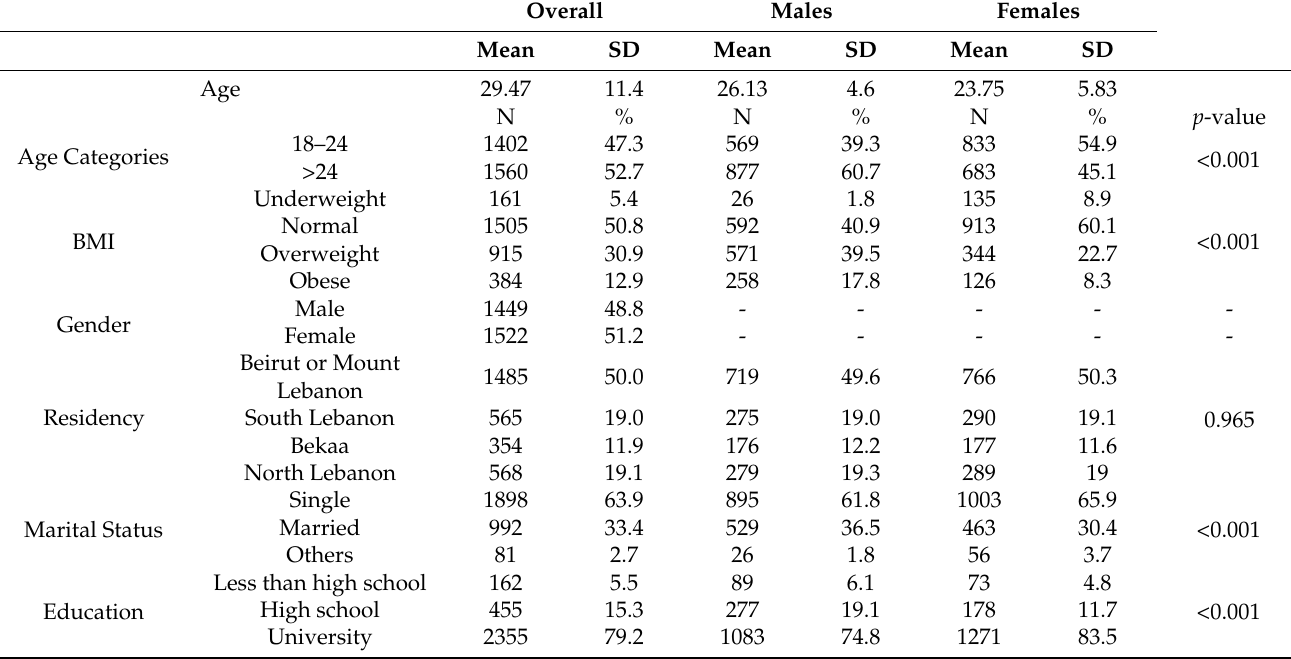
Table 1. Demographic and socio-economic characteristics of the study population, overall and by